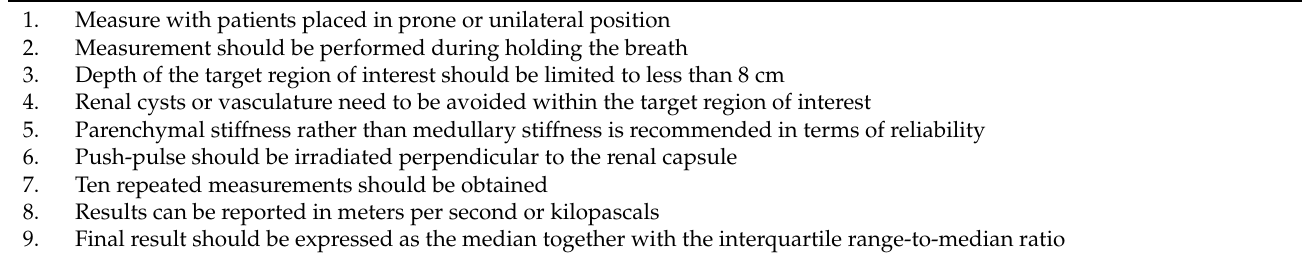
Table 1. Proposal for measuring renal elasticity with the SWE